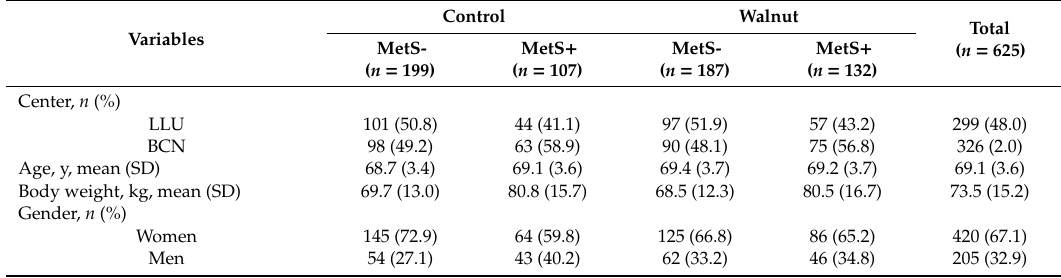
Table 1. Baseline characteristics of participants by intervention